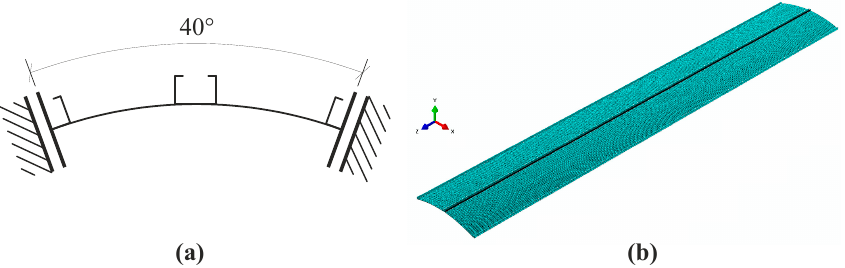
Figure 2. ( a ) Scheme of boundary conditions in simplified silo segment; ( b ) Visualisation of numerical model.